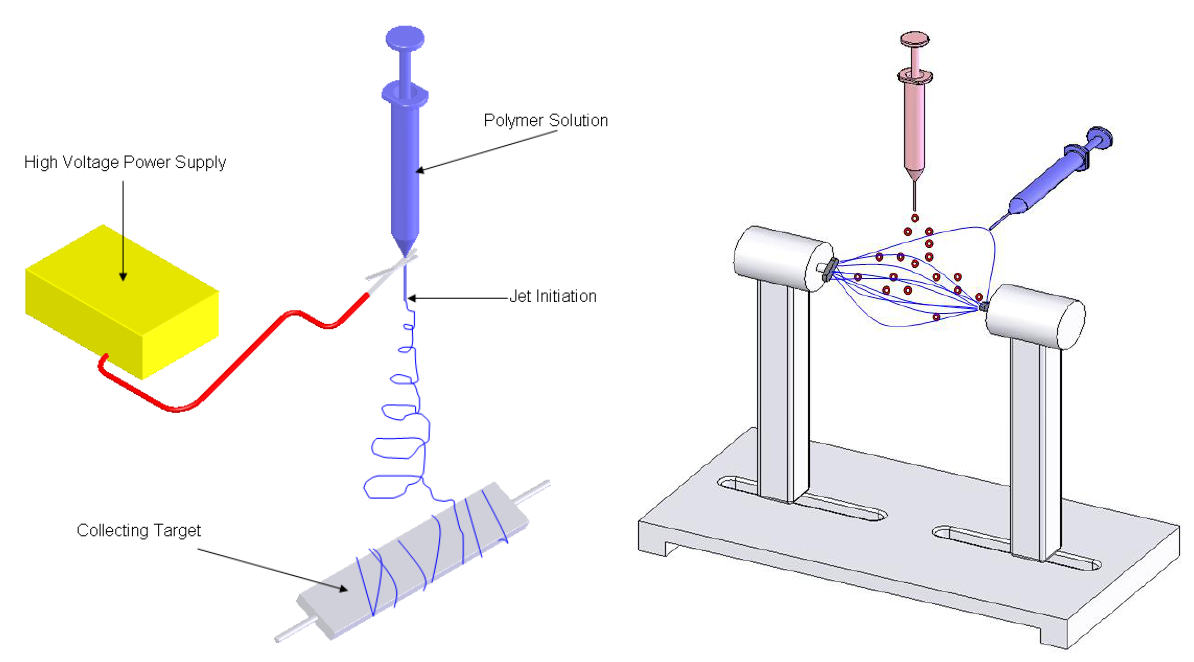
Figure 2. Schematic representation of a traditional electrospinning setup with a horizontal orientation (Left), and the simultaneous microintegration of cells and electrospun polymer using an airgap electrospinning setup